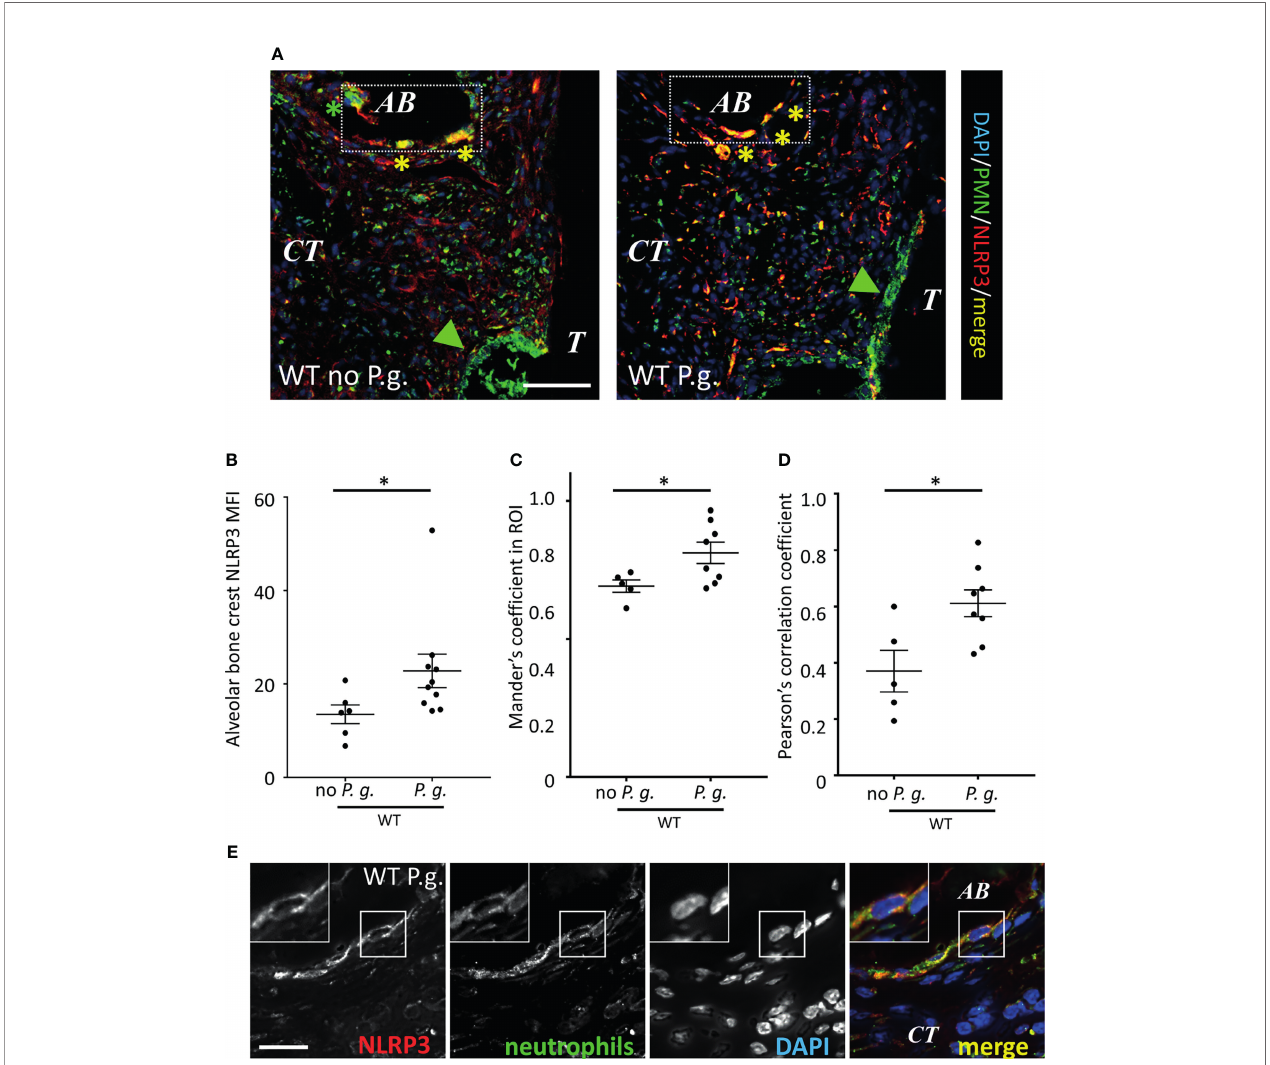
FIGURE 8 | Neutrophils recruited around alveolar bone express NLRP3. (A) Neutrophils and NLRP3 were detected by immuno fl uorescence using speci fi c antibodies. Bar = 100 m m. (B) NLRP3 mean of fl uorescence intensity (MFI) was measured in a (130 µm length) x (10 µm thick) segmented line surrounding the alveolar bone crest. Green arrowheads show sulcular neutrophils, yellow asterisks show NLRP3-expressing alveolar bone neutrophils (C, D) Population analysis of the co-expression between NLRP3 and neutrophil marker. Mander ’ s (C) and Pearson ’ s (D) coef fi cients are shown. (B – D) Each dot represents a single mouse. Horizontal bars represent the mean +/- SEM. Unpaired Welch ’ s T test. *P < 0.05. (E) Enlargement shows a single neutrophil close to alveolar bone (AB) expressing NLRP3 in WT mice treated with P. gingivalis . Bar = 10 m